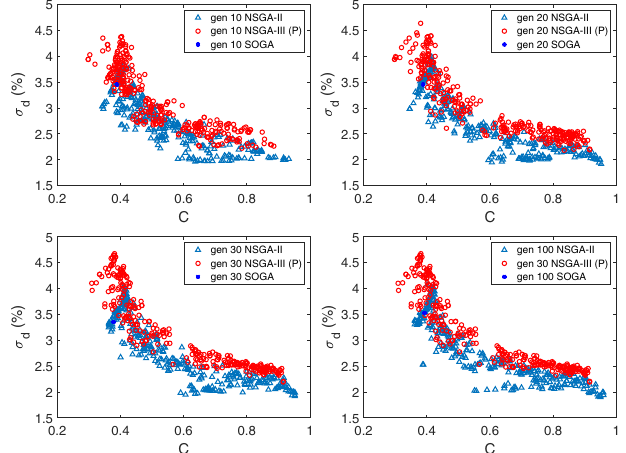
FIG. 10. Projection of the Pareto-optimal front obtained by the NSGA-II and NSGA-III (P) with a population size of 300 in different generations. And the best solutions achieved by the SOGA in different